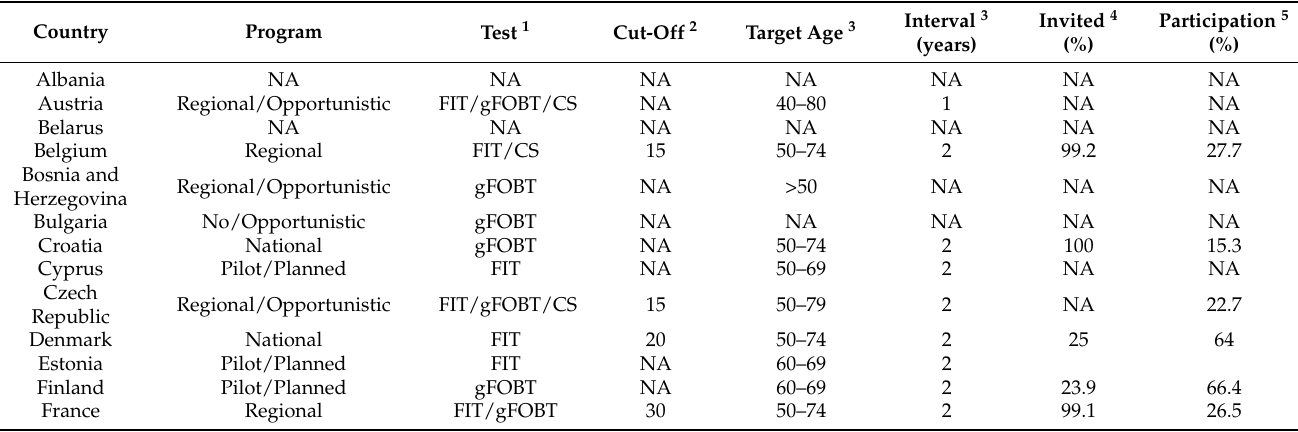
Table 1. Colorectal cancer (CRC) screening in Europe